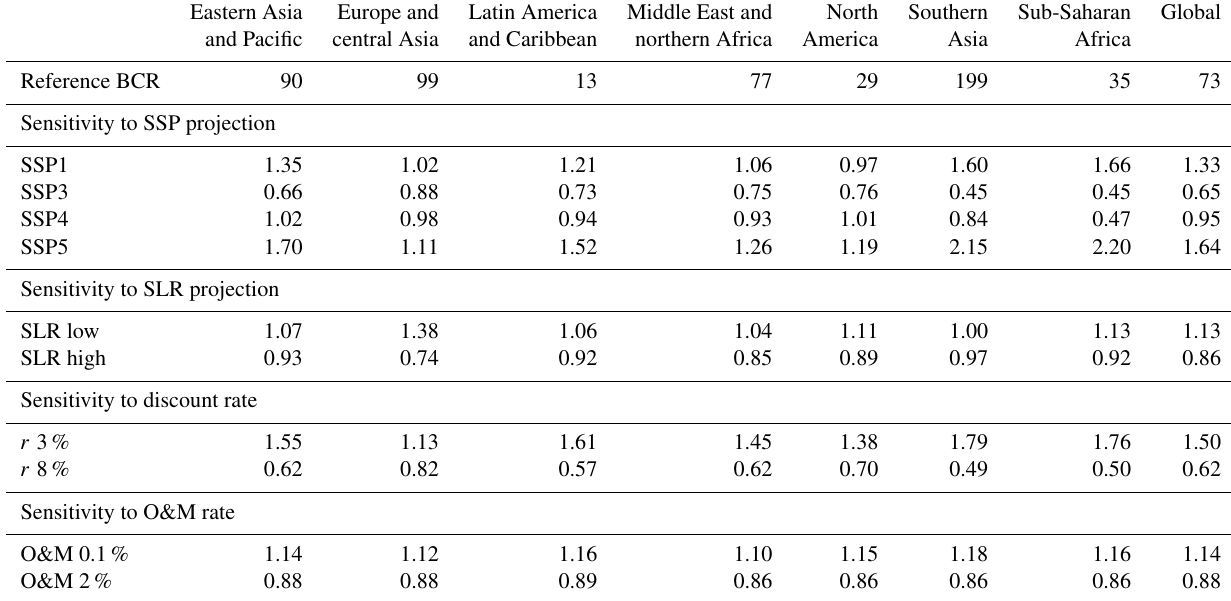
Table 2. Sensitivity analysis of model runs with different input parameters. BCRs are standardized to the model run with RCP4.5–SSP2, discount rate of 5%, and O&M costs of 1%. SLR low refers to sea-level rise using the 5th percentile and SLR high to the 95th